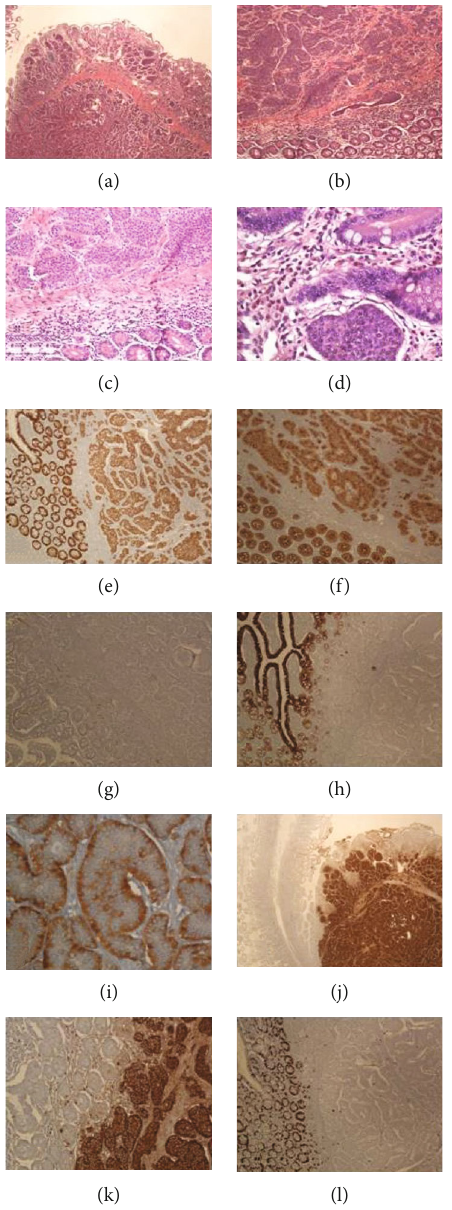
Figure 3: Histopathology features of one of the cases, well-di ff erentiated neuroendocrine tumor of the small intestine (ileum), classic type: (a – c) the histological sections show tumor cells with minimal pleomorphism arranged in cording and nesting growth patterns, extensively involving the mucosa, submucosa, and muscle layer. The main bulk of the tumor is seen in the submucosa and the muscle layer. The tumor cells have stippled chromatin, inconspicuous nucleoli, and slightly granular eosinophilic cytoplasm. There is no signi fi cant mitotic activity, and the tumor cells show little pleomorphism. There is no cell necrosis (H&E stains: (a) × 4, (b) × 10, (c) × 20, and (d) × 40). The tumor cells were positive for the epithelial markers CDX-2 ((e) × 10) and pancytokeratin ((f) × 10) and negative for CK7 ((g) × 10) and CK20 ((h) × 10). The tumor cells were di ff usely and strongly reactive for the markers of neuroendocrine di ff erentiation including both synaptophysin ((i) × 40) and chromogranin ((j) × 4 and (k) × 10). Ki67 labelling index was very low (less than 1%, (l) ×